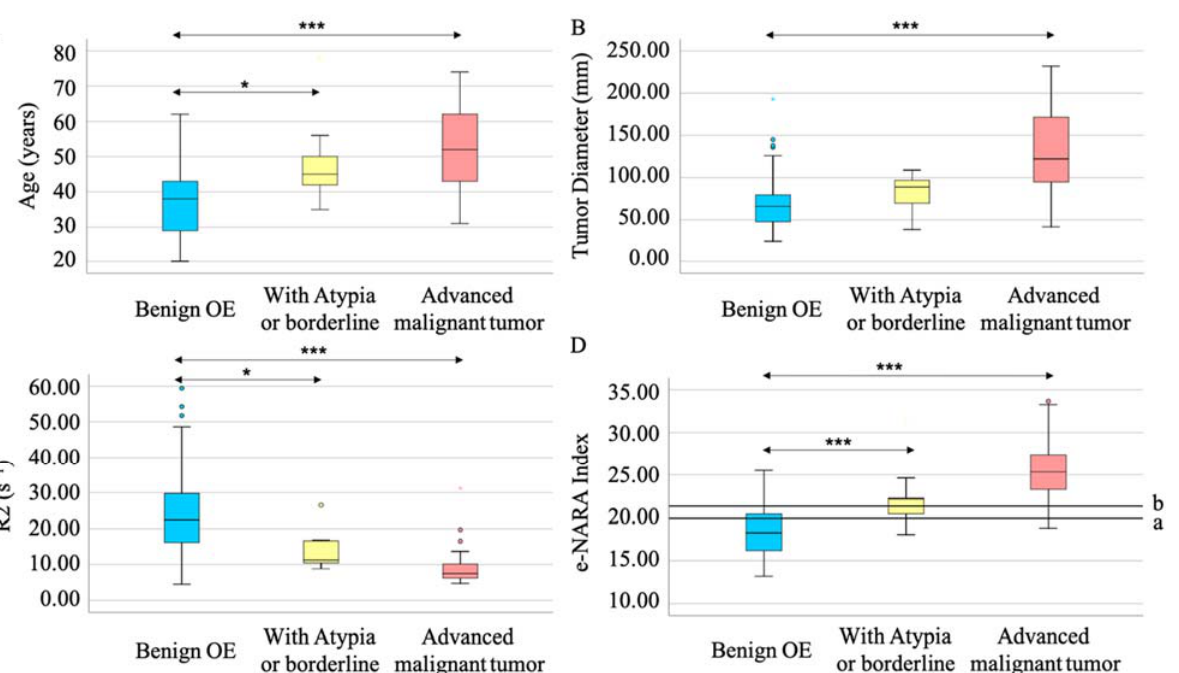
Table 6. The cut-off values among benign OE, atypia or borderline tumor, and advanced malignant tumor in the current cohort.